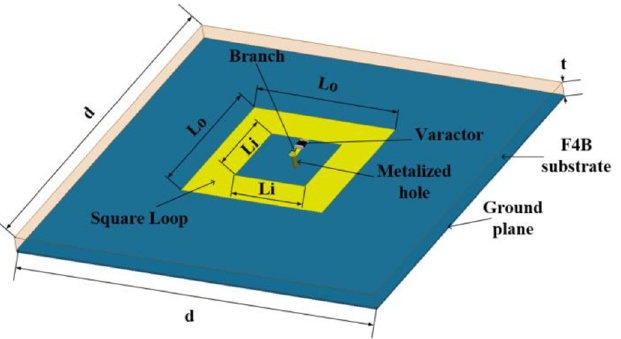
Fig. 3. Perspective view of re fl ective element.